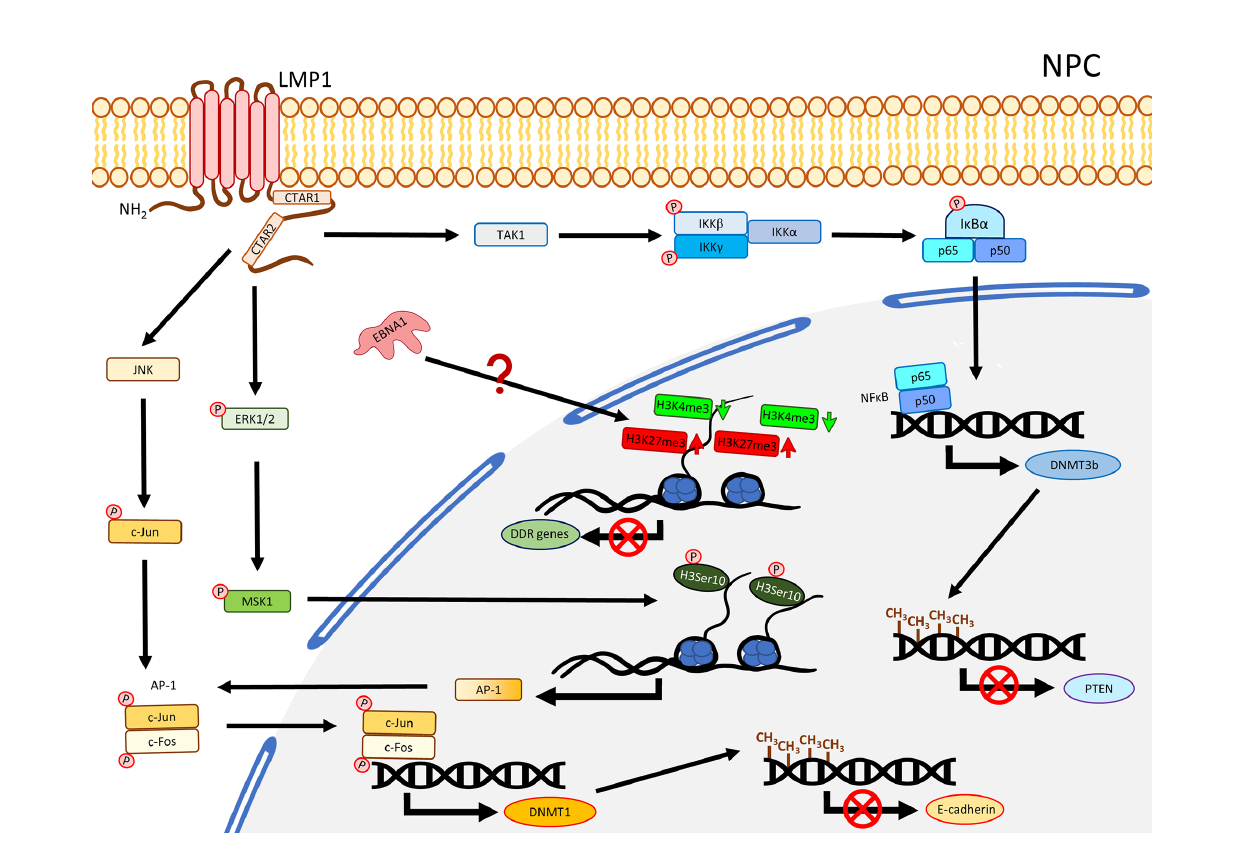
FIGURE 1 | A schematic diagram shows the impact of EBV on epigenetic dysregulation in NPC. LMP1 activates JNK and NF k B signaling pathways to enhance expression of DNMTs, resulting in promoter DNA hypermethylation in the TSGs including CDH1 (encoding E-cadherin) and PTEN . LMP1 may also promote phosphorylation of ERK1/2, resulting in phosphorylation of H3Ser10 to activate the expression of AP-1. Up-regulation of EBNA1 inhibits DDR genes expression probably through dysregulating bivalent switches in NPE cell